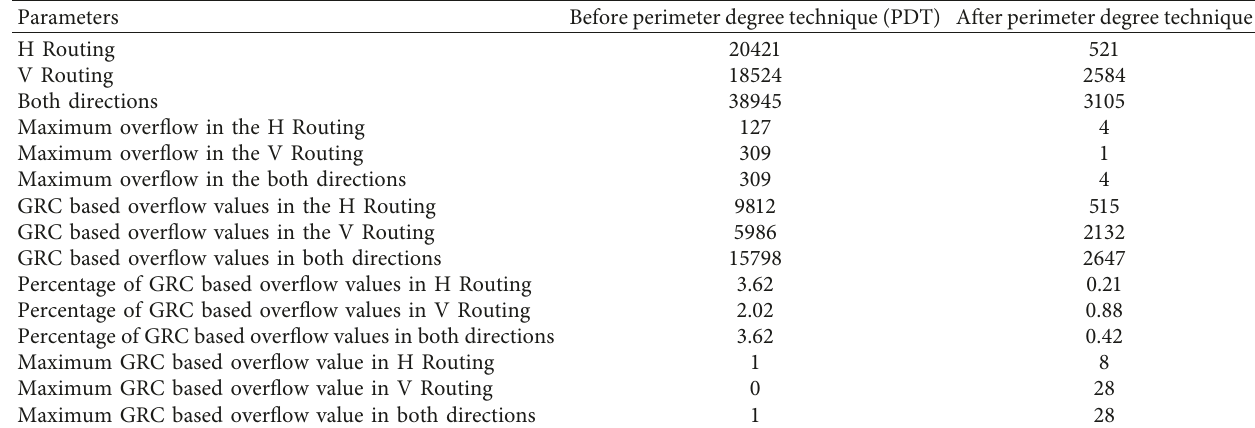
Table 2: Statistical Comparison of several metrics before and after the proposed congestion (PDT) estimation technique was